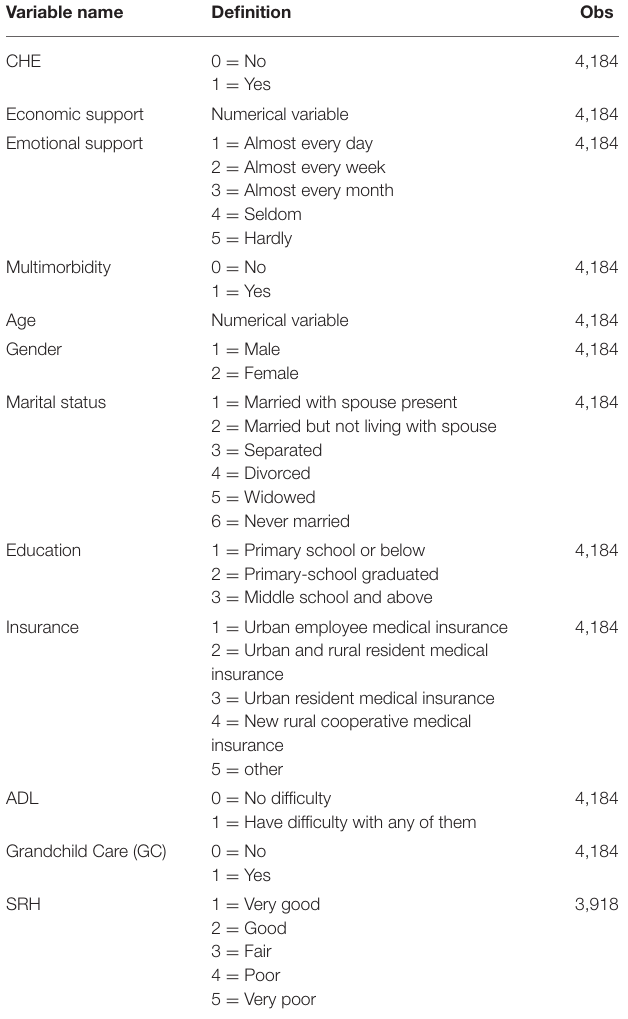
TABLE 1 | Description of